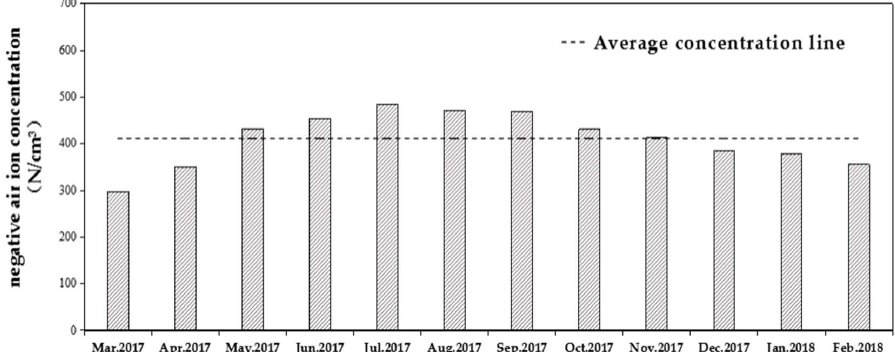
Figure 3. Monthly variation of NAIs in Zhongshan Park.